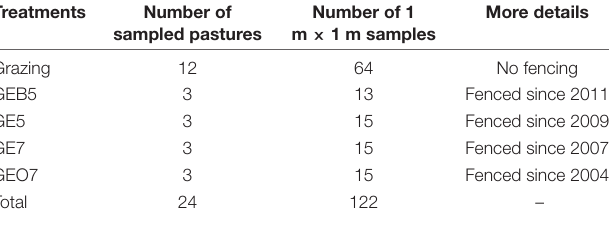
TABLE 1 | Details on the samples conducted in continuously grazed pastures (Grazing), grazing exclusion below 5 years (GEB5), grazing exclusion 5 years (GE5), grazing exclusion 7 years (GE7), and grazing exclusion over 7 years (GEO7). Treatments Number of More sampled pastures